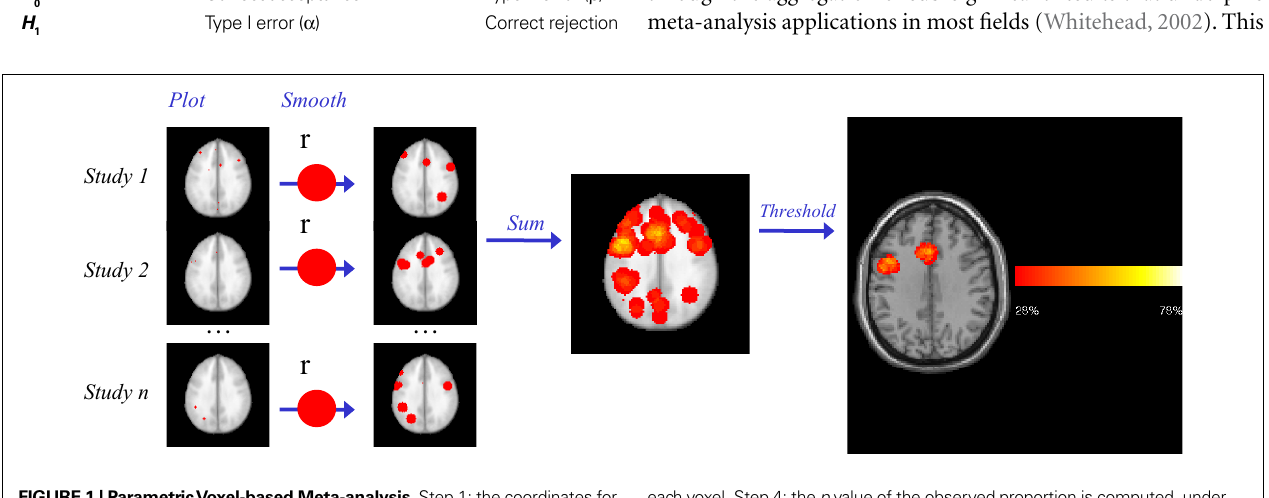
FIGURE 1 | Parametric Voxel-based Meta-analysis. Step 1: the coordinates for each study are plotted in standard space brain (MNI). Step 2: After smoothing with a uniform kernel of size r , each study map is transformed into an indicator map, where voxels with 1 values (red) indicate the presence of at least one activation within distance r . Step 3: all study-level indicator maps are summed and then divided by the number of studies n , to obtain a summary map refl ecting the proportion of studies reporting an activation within distance r of